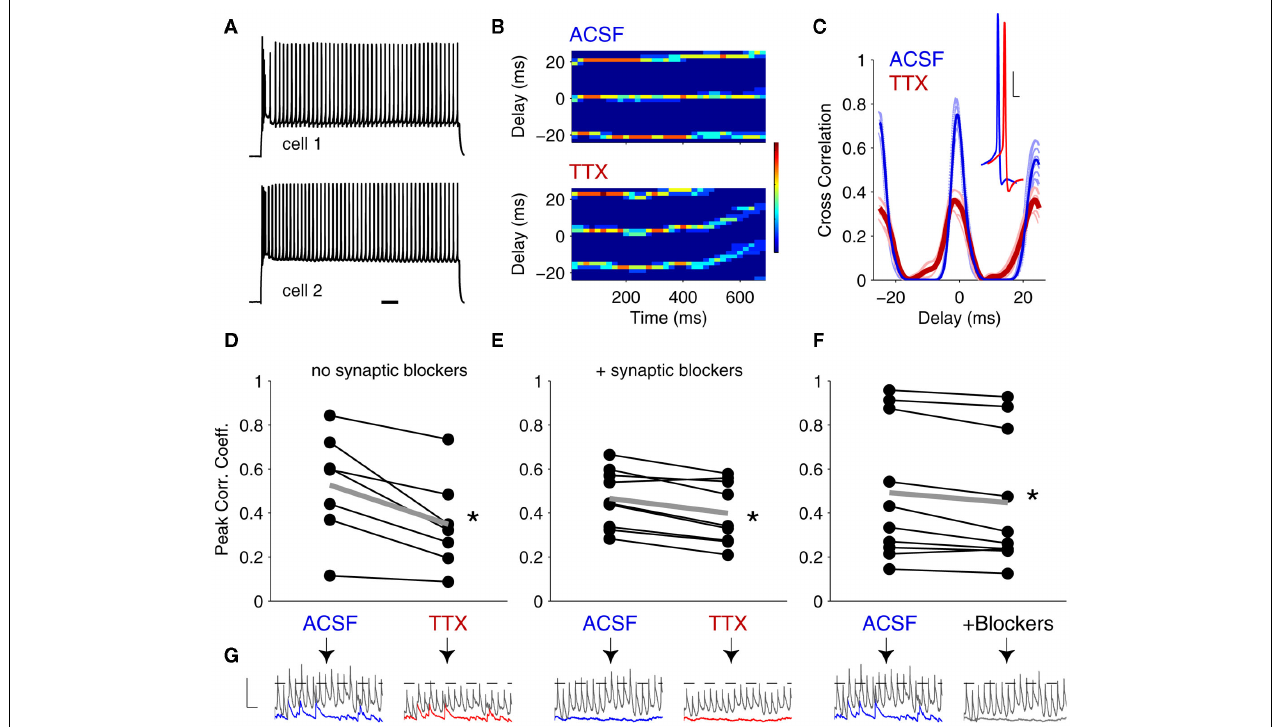
FIGURE 3 |Tonic-spike synchrony in coupled neurons is enhanced synergistically by I NaP and spontaneous synaptic input. (A) A pair of gap junction-coupled neurons driven to spike at similar frequencies. Scale bar 100ms. (B) Time-course cross-correlograms for a pair of electrically coupled neurons in control (ACSF) and following 100nMTTX application. In both conditions, spikes fired at ∼ 50Hz; color bar represents 0 (navy) to 7 (dark red) correlated spikes within a given 50ms window ( y -axis); bin width = 2ms. (C) Example cross-correlogram for paired spiking before (blue) and after (red)TTX application. Inset: spikes in aTRN cell in ACSF (blue) and in 100nMTTX (red). Scale bar is 10mV, 2ms. (D) Peak correlation coefficients before and afterTTX. InTTX, correlation coefficients were 34.4 ± 5.9% lower than in ACSF (mean ± SEM, N = 7 pairs, p <